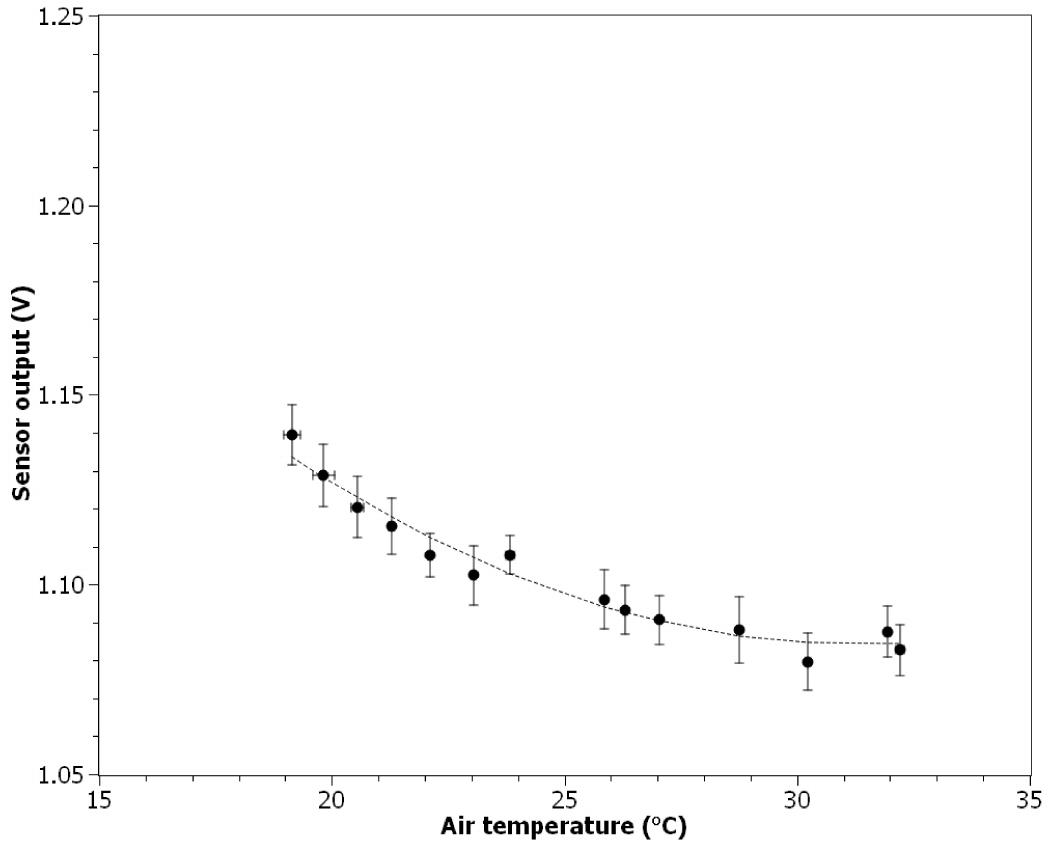
Figure 8. Ionization sensor output signal change in relation to air